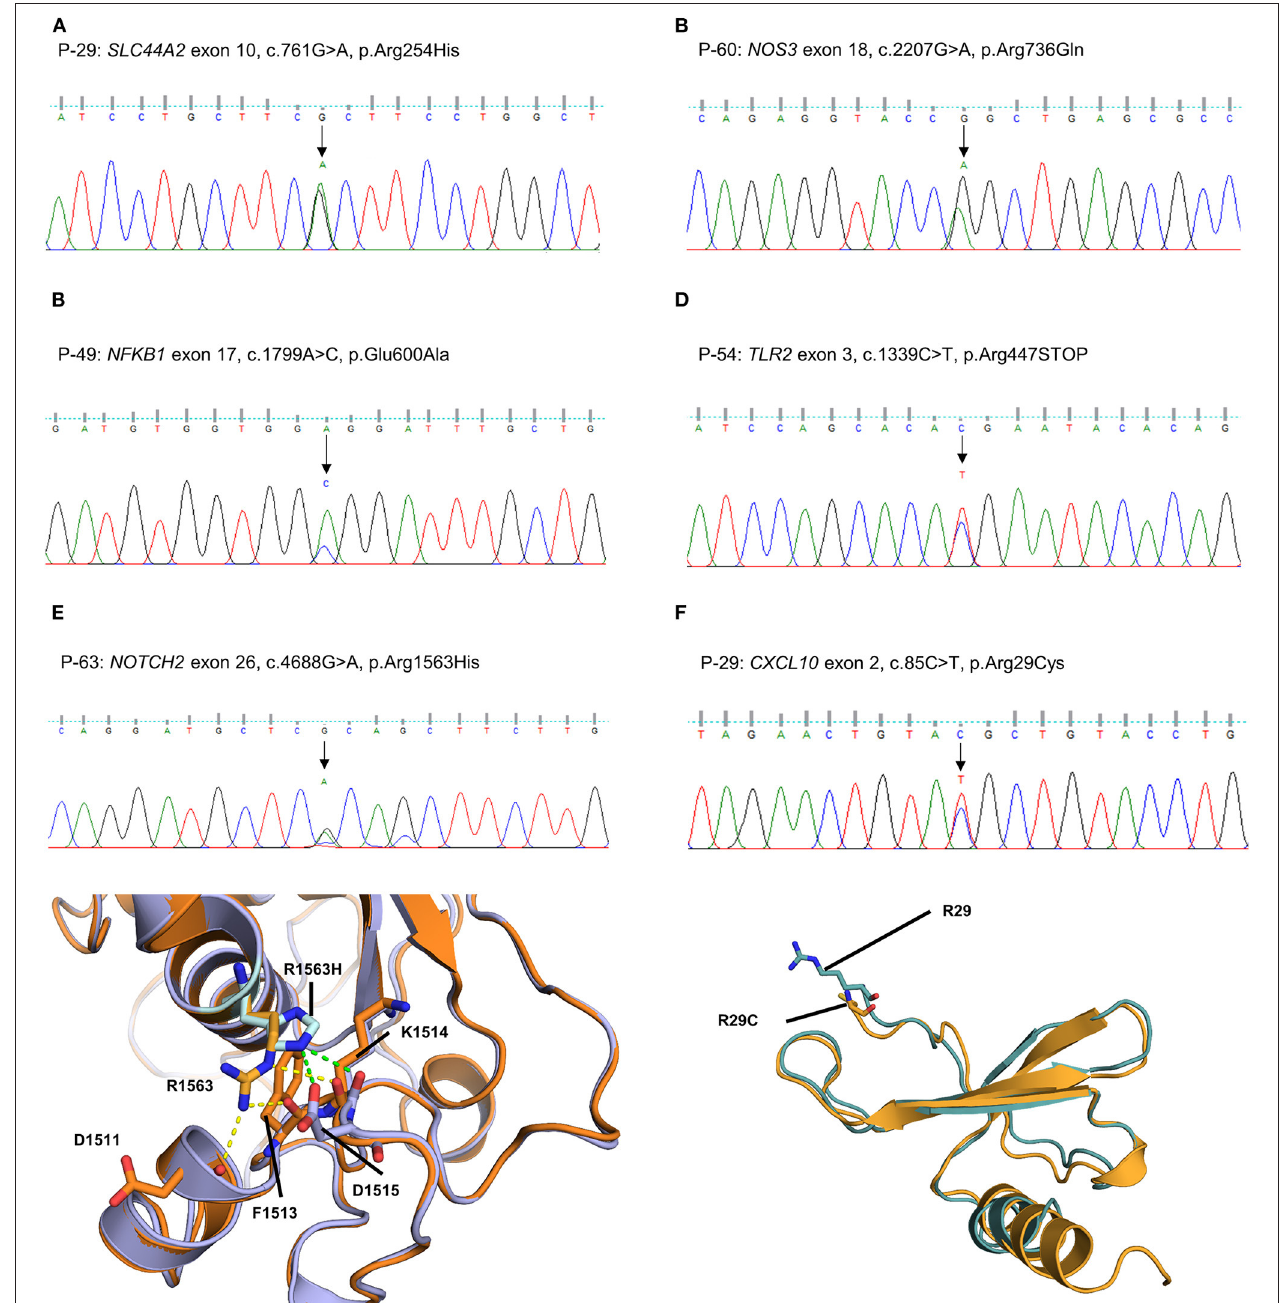
FIGURE 4 | Sequencing results and protein structural modeling of the rare variants in other MD-associated genes identified by targeted next-generation sequencing. (A–D) The chromatograms show a heterozygous missense rare variant in SLC44A2 (exon 10, c.761G > A, p.R254H, P-29), NOS3 (exon 18, c.2207G > A, p.R736Q, P-60), and NFKB1 (exon 17, c.1799A > C, p.E600A, P-49), and a nonsense variant in exon 3 of TLR2 causing premature stop codon (c.1339C > T, p.R447X, P-54). (E) P-63 has a heterozygous missense variant in exon 26 of NOTCH2 causing the substitution of highly conserved arginine by histidine at position 1563 (c.4688G > A, p.R1563H). In protein structural modeling, p.R1563H variant may result in loss of interaction with p.D1511 and p.F1513 residues, and form new hydrogen bond network with main chain of p.K1514 residue and side chain of p.D1515 (green dash line). These impaired interactions make p.D1515 residue to lose ability to interact with a calcium ion, and eventually destabilize the Lin-12/Notch repeat domain required for regulating the NOTCH2 receptor (orange: wild type NOTCH2, purple: p.R1563H mutant NOTCH2). (F) P-29 had a heterozygous missense rare variant in exon 2 of CXCL10 causing the substitution of highly conserved arginine by cystein at position 85 (c.85C > T, p.R29C). However, there is no conformational change in overall structure because the R29 residue is located at the N-terminal end and not involved in interaction with neighboring residues (teal: wild type CXCL10, orange: p.R29C mutant CXCL10).